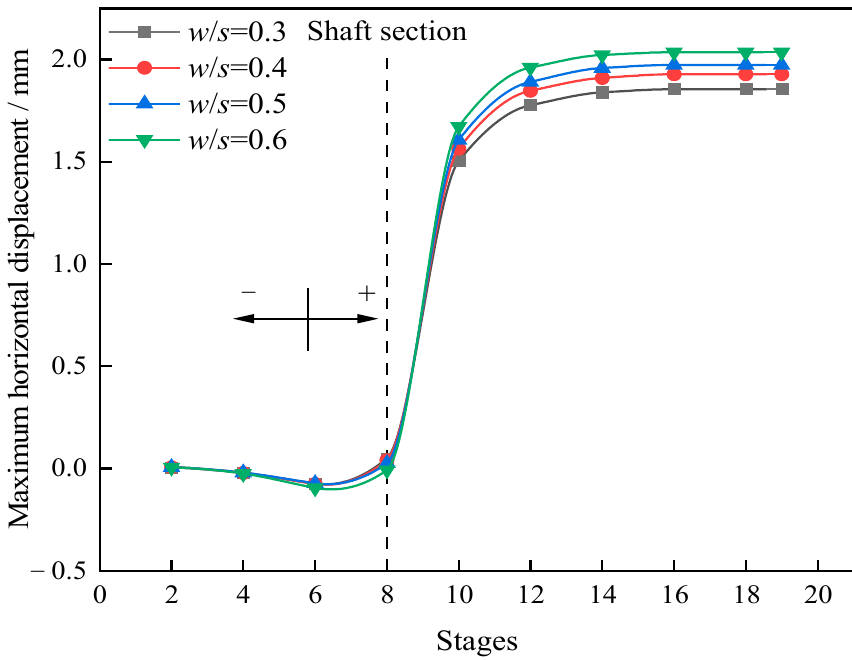
Figure 24. Relationship between maximum vertical displacement and width–span ratio.